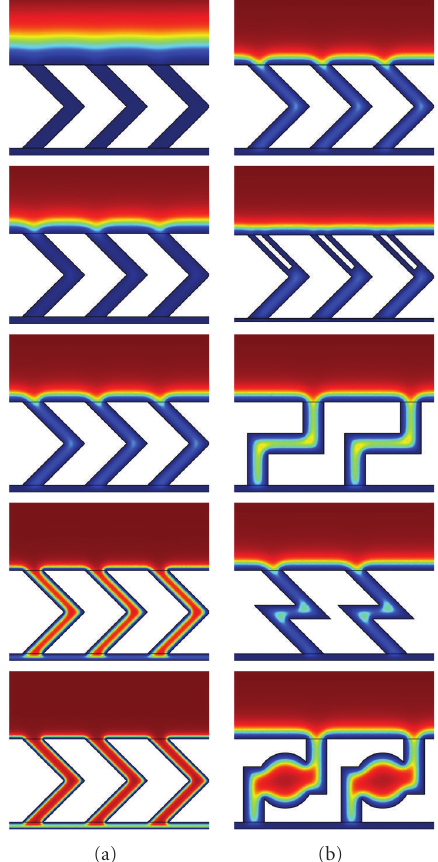
Figure 6: Simulation of the electron density by sheath model penetration of plasma into slots (a) at various plasma densities, and impact of the slot geometry (b) on plasma presence in the slot. The plots from top to down in column (a) represent simulation results at various bulk plasma density, that is, 1 × 10 9 cm − 3 , 5 × 10 9 cm − 3 , 1 × 10 10 cm − 3 , 5 × 10 10 cm − 3 , and 1 × 10 11 cm − 3 . Plots in column (b) are computed at bulk plasma density 1 × 10 10 cm − 3 .